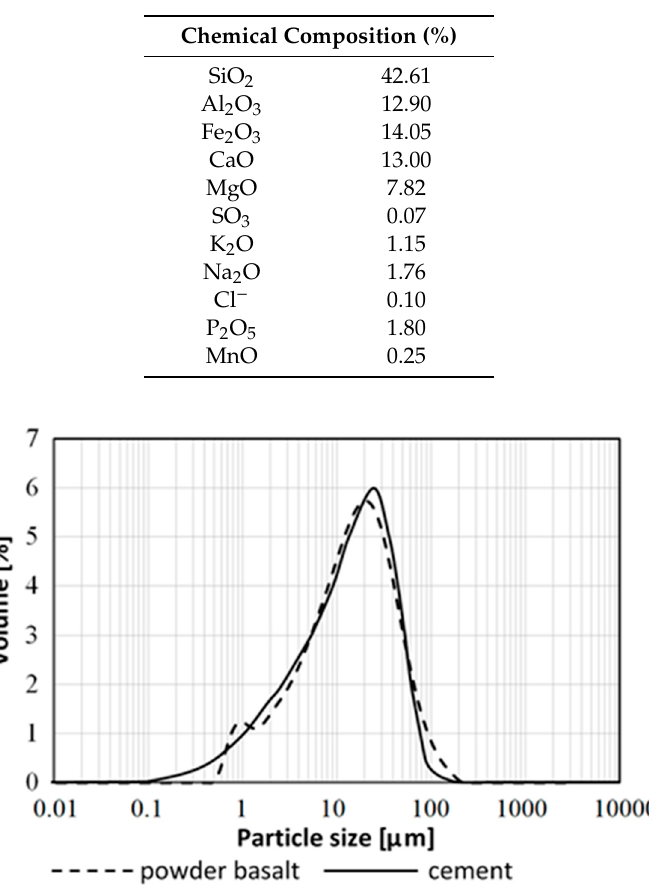
Table 1. Chemical composition of basalt powder.